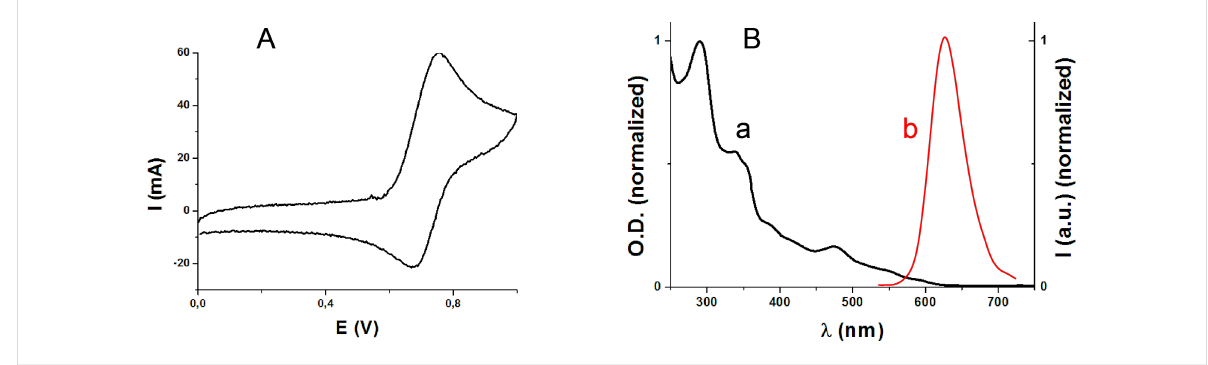
Figure 7: (A) cyclic voltamogramm for Ir(piq) 2 (tmd) in acetonitrile; (B) absorption (a) and luminescence (b) spectra for Ir(piq) 2 (tmd) (in acetonitrile).